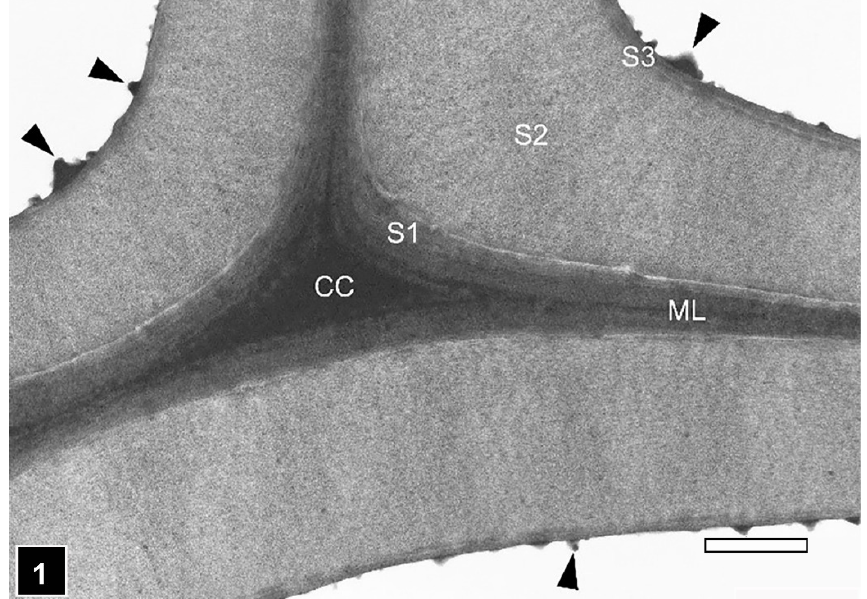
Figure 1. TEM of a transverse section through silver fir ( Abies alba Mill.) tracheids. The secondary cell walls display a lamellar organisation. CC, cell corner; ML, middle lamella; S1, S2, S3, secondary wall layers; warts (arrowheads). Scale bar = 1 µ m. The image is courtesy of Prof. Jong Sik KIM, Chonnam National University, South